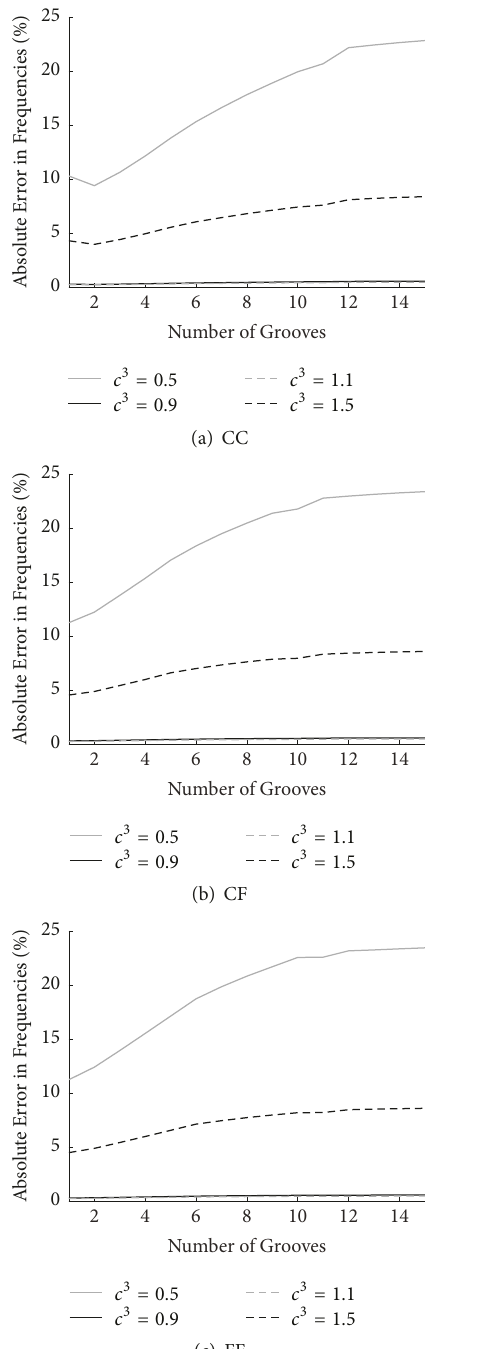
Figure 13: Frequency errors for variable groove number and first- order gradient minimization.